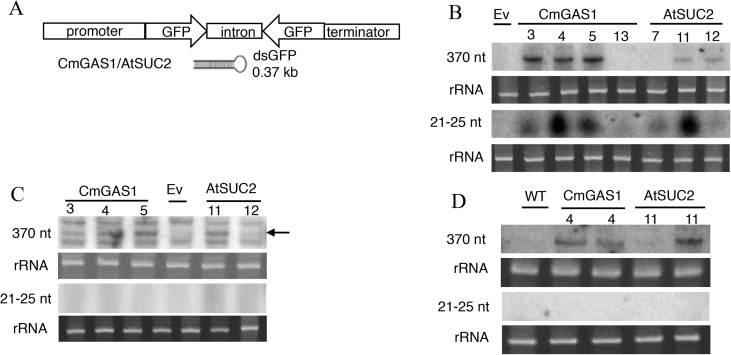
Northern blot analyses of ds-GFP in transgenic tomato plants and whiteflies feeding on the plants. (A) Map of transformation vectors for ds-GFP expression, designed to produce 370 bp hairpin-ds-GFP (hp-ds-GFP) under companion cell-specific promoter CmGAS1 or AtSUC2; (B) 370 nt ds-GFP (top) and 21–25 nt small RNA (bottom) in the plants. (C) 370 nt ds-GFP (horizontal arrowhead) in cohorts of ca. 250 whiteflies that had fed on transgenic plants for two weeks. (D) RNA gel blot analysis of RNA extracted from the scion apex heterografted (GAS1:4 and SUC2:11) plants. Numbers indicate transgenic tomato lines, with Ev comprising plants transformed with the empty vector, and WT comprising non-transformed tomato plants. Twenty μg total leaf or whitefly low molecular weight RNA (LMW) and high molecular weight RNA (HMW) were separated on 8% denatured urea-acrylamide gel, with the HMW RNA hybridization protocol for full-length ds-GFP detection and LMW RNA hybridization protocol for small RNA detection. The rRNA loading control is SybrGold stained 5S rRNA.